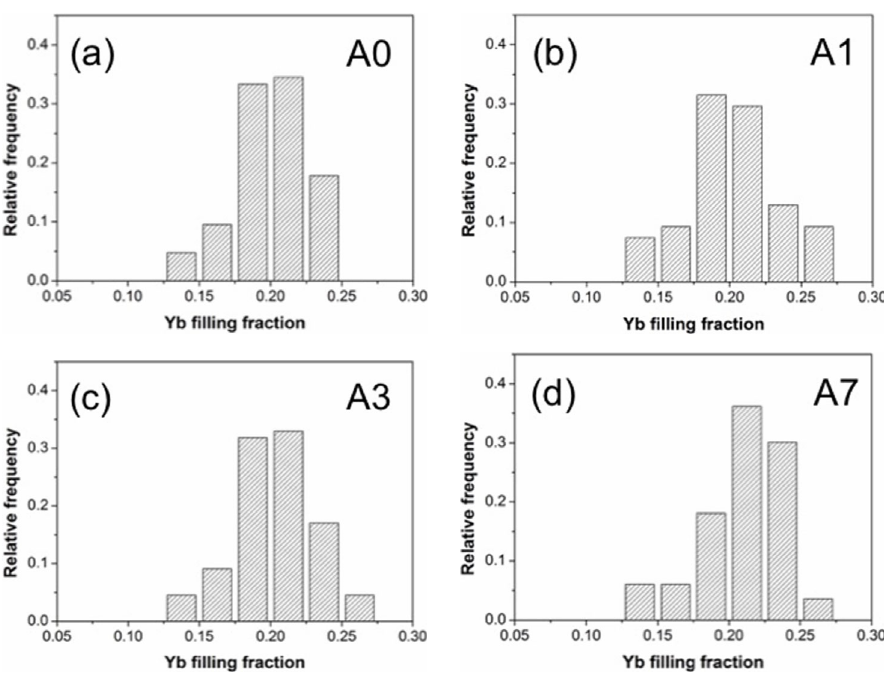
Fig. 9 Yb filling fraction distribution in the samples A0, A1, A3, and A7. Note that the data of (a) just measured from the areas of skutterudite phase in the sample